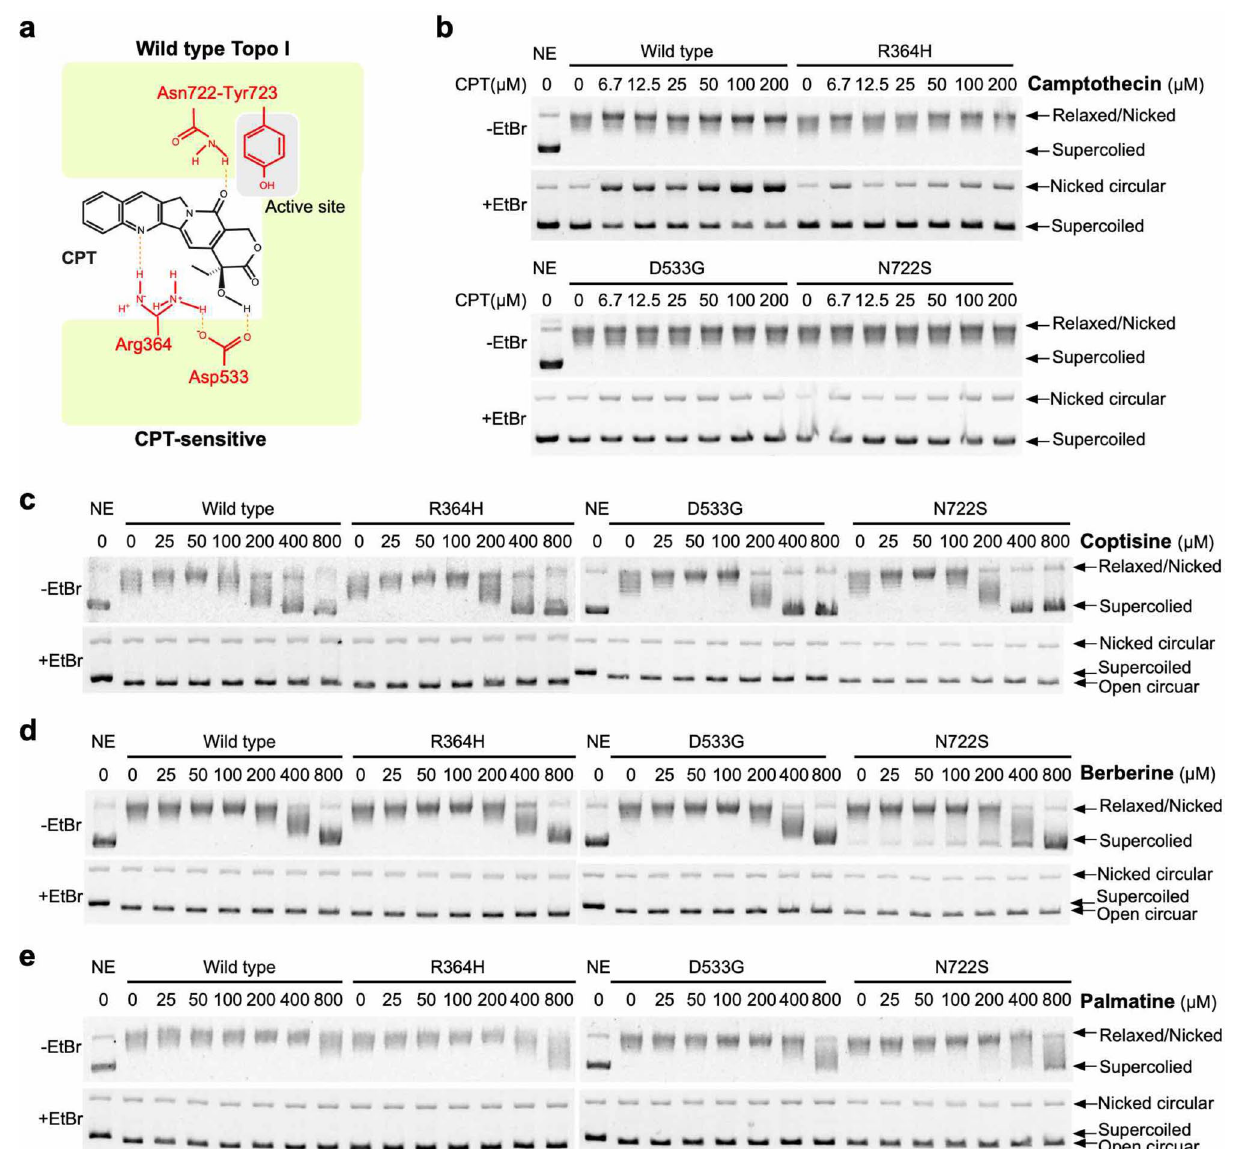
Figure 7. Analysis of the inhibitory effects of BIAs against CPT-resistant Topo I proteins. ( a ) Schematic representation of CPT-resistant TOP1 mutations. ( b ) Relaxation activity of CPT-resistant Topo I proteins in the presence of CPT in vitro. ( c ) Inhibitory effect of coptisine, berberine, epiberberine and palmatine on CPT- resistant Topo I proteins in